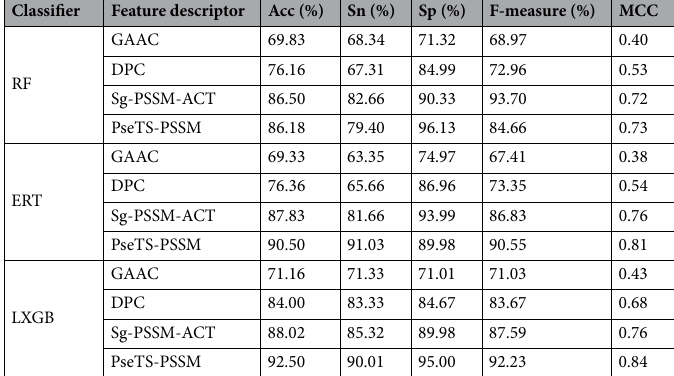
Table 2. Results based on single feature descriptor.